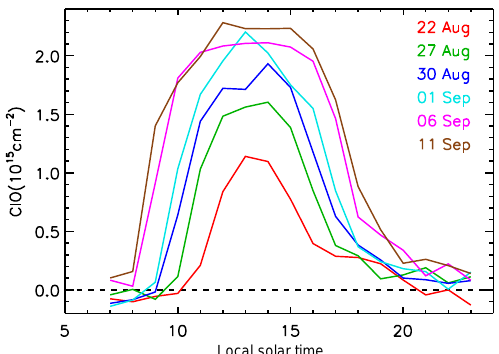
Figure 4. The diurnal variation of ClO column density at altitudes above 100hPa at Scott Base as measured from a series of measure- ment days in 2005. The date given for each curve is the middle date of a 3-day average of hourly